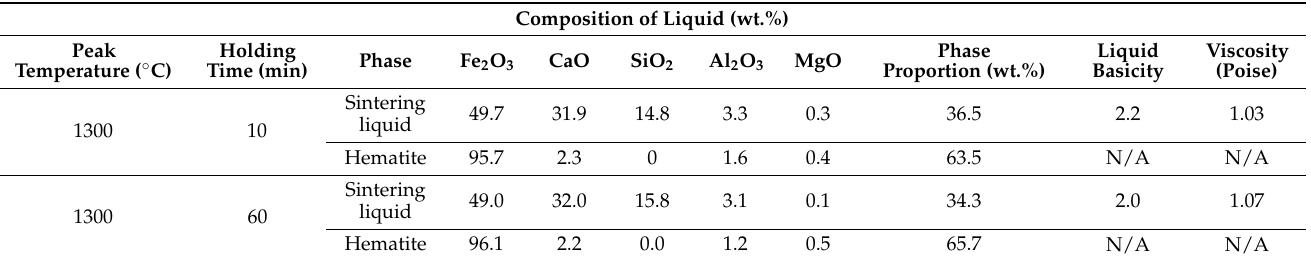
Figure 6. Microstructural BSE images of reheated S2 sinters at different holding times. ( a ) 10 min, and ( b ) 60 min. Table 4. Phases present and phase compositions in sinter ‘S2’ upon reheating for two different holding times of 10 min and 60 min at 1300 ◦